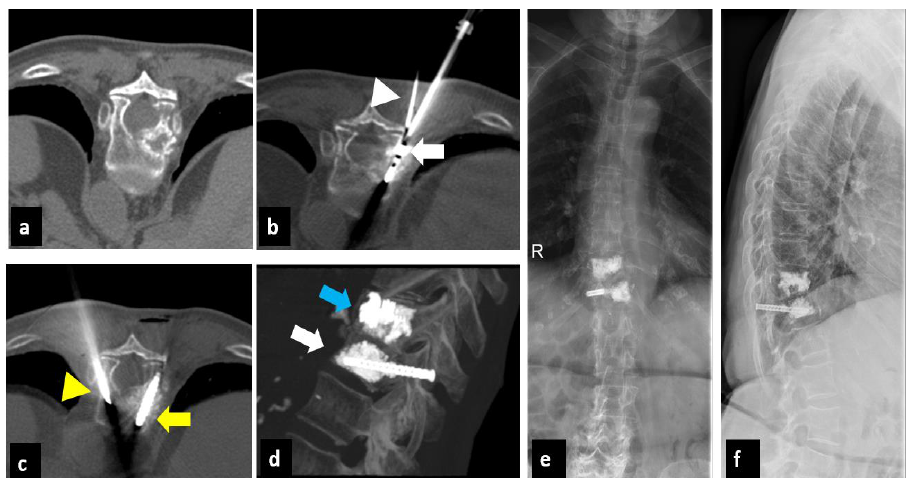
Figure 3. A 84-year-old woman with history of breast cancer, treated with simple vertebroplasty for pathologic D11 vertebral fracture 3 years earlier. ( a ): Axial CT scan shows osteolytic metastasis of vertebral body D12 involving the right pedicle. ( b ): Axial CT shows placement of the thermocouple (white arrowhead) in the right anterior epidural space and transpedicular placement of the MW antenna (white arrow) in the D12 vertebral body for thermal ablation. ( c ): Axial CT shows the placement of the right screw (yellow arrow) and contralateral advancement of the vertebroplasty cannula (yellow arrowhead). ( d ): Postoperative sagittal CT with Maximum Intensity Projection (MIP) reconstruction after microwave ablation of D12 vertebra combined with pedicle screw fixation followed by vertebroplasty (white arrow). Vertebroplasty of D11 performed 3 years earlier (blue arrow). ( e , f ): Radiograph of the thoracolumbar spine 3 months after surgery, in antero-posterior and latero-lateral projection, after microwave ablation of the D12 vertebra combined with pedicle screw fixation followed by vertebroplasty (MASFVA).